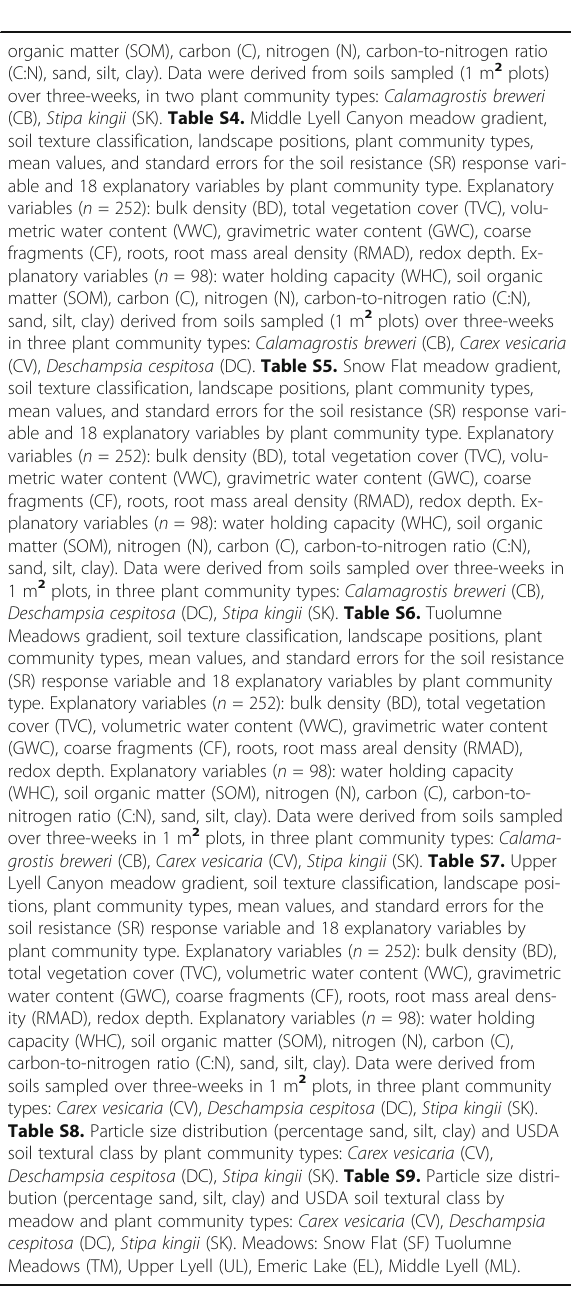
Table S8. Particle size distribution (percentage sand, silt, clay) and USDA soil textural class by plant community types: Carex vesicaria (CV), Deschampsia cespitosa (DC), Stipa kingii (SK). Table S9. Particle size distri- bution (percentage sand, silt, clay) and USDA soil textural class by meadow and plant community types: Carex vesicaria (CV), Deschampsia cespitosa (DC), Stipa kingii (SK). Meadows: Snow Flat (SF) Tuolumne Meadows (TM), Upper Lyell (UL), Emeric Lake (EL), Middle Lyell (ML). Abbreviations AIC: Akaike information criterion; ANOVA: Analysis of variance; BD: Bulk density; BIC: Bayesian information criterion; CM: Calamagrostis muiriana ; CV: Carex vesicaria ; DC: Deschampsia cespitosa ; FAC: Facultative; FACU: Facultative upland; FACW: Facultative wetland; GWC: